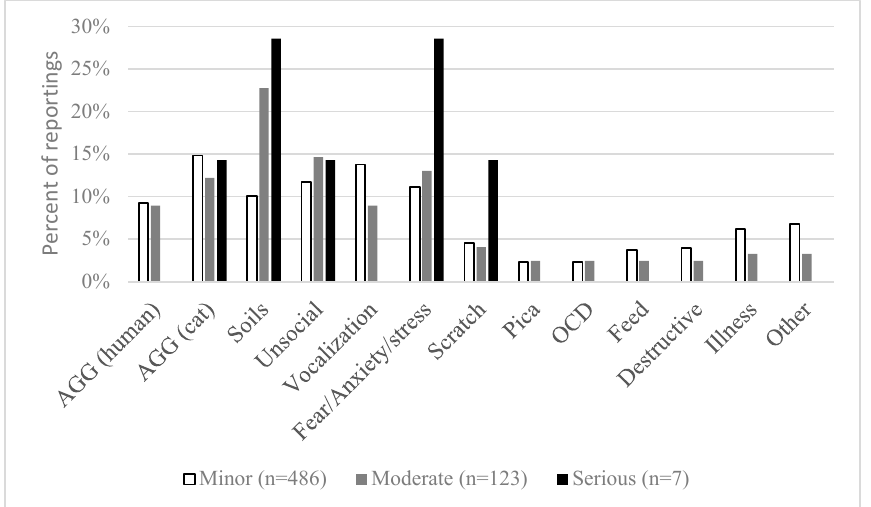
Figure 1. Distribution of the 616 reported perceived issues with behavior derived from the free text option for respondents ( n = 549) stating that they experienced some form of problem with their cat’s behavior. AGG—aggressive toward familiar humans or cats; Soils—all forms of elimination problems; Unsocial—exhibiting fear and/or aggression toward familiar or unfamiliar people; Vocaliza- tion—undesired or excessive vocalization; Fear/Anxiety/Stress—described as exhibiting fear and/or anxiety and/or stress; Scratch—scratching furniture, walls, plants, etc.; Pica—ingestion of non-nu- tritive substances; OCD—obsessive/compulsive disorders; Feed—feed and feeding related prob- lems; Destructive—cats described as waking owners during night and exhibiting destructive behav- iors such as turning over items; Illness—issues relating to illness and pain; Other—all answers that could not be categorized. Table 3. The distribution of the perceived temperamental problems, directly translated and sug- gested answers of the respondents ( n = 43) reporting only issues with their cat’s temperament. Temperamental Problem 1 A chi-square test of independence was used to investigate the association between outdoor access and the owner perceived behavioral or temperamental problems. There was an association between outdoor access and perceived behavioral or temperamental problems χ 2 (1, N = 3241) = 16.255, p = 0.0001, φ = 0.1. Cat owners keeping cats with outdoor access had a lower observed reporting of problems than expected by chance. No associa- tion was found between the time left alone and perceived behavioral or temperamental problems χ 2 (6, N = 3253) = 10.76 p = 0.096, φ = 0.1.